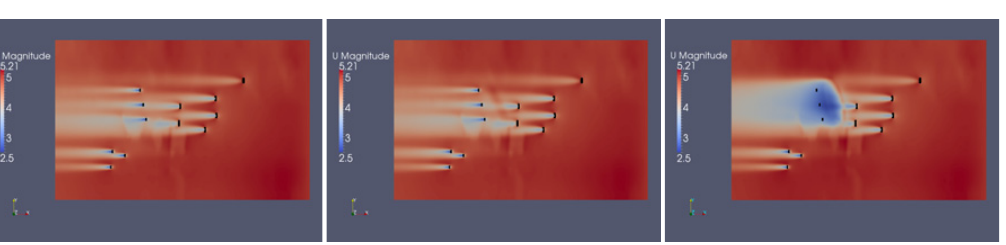
Figure 2. Elevation in meters (left) of the orography of the wind park under study. The red oval mountain represents the planned landfill mound (case A). The black ovals represent the actuator disks of the wind turbines. The incoming wind direction is WSW (240 ◦ ). The figure on the right shows the position of the porous cells representing the alternaive forest position (case B). The black, blue and red disks are E-40 (65 m hub height), E-66 (98 m hub height) and E-82 (108.4 m hub height) wind turbines, respectively.